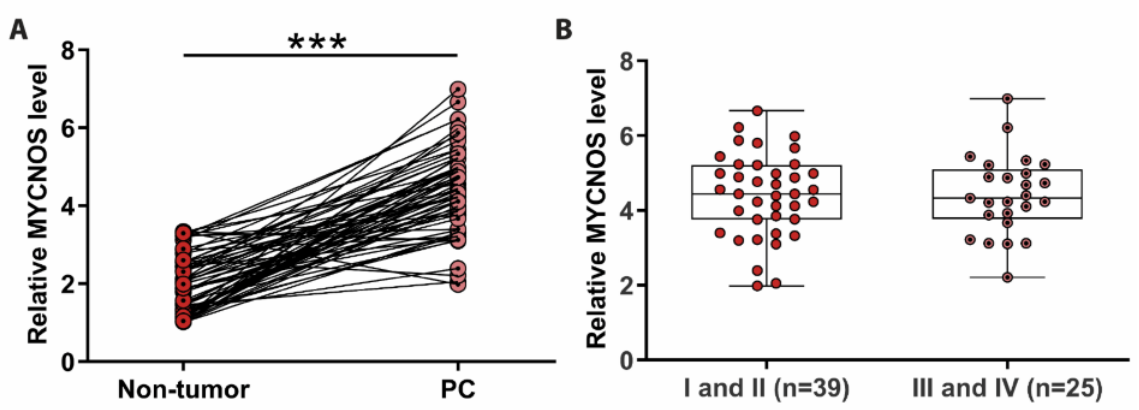
Figure 1. Upregulation of MYCNOS was observed in PC tissues. (A) Expression of MYCNOS in paired PC and non-tumor tissues collected from 64 PC patients was determined by RT-qPCR. Average values of three technical replicates were used to express MYCNOS expression levels in paired tissues, *** p < 0.001. (B) MYCNOS expression levels in PC tissues were also compared between stage I/II and stage III/IV ( p > 0.05). The top, middle, and bottom horizontal lines mean the upper quartile, median value, and lower quartile, respectively.